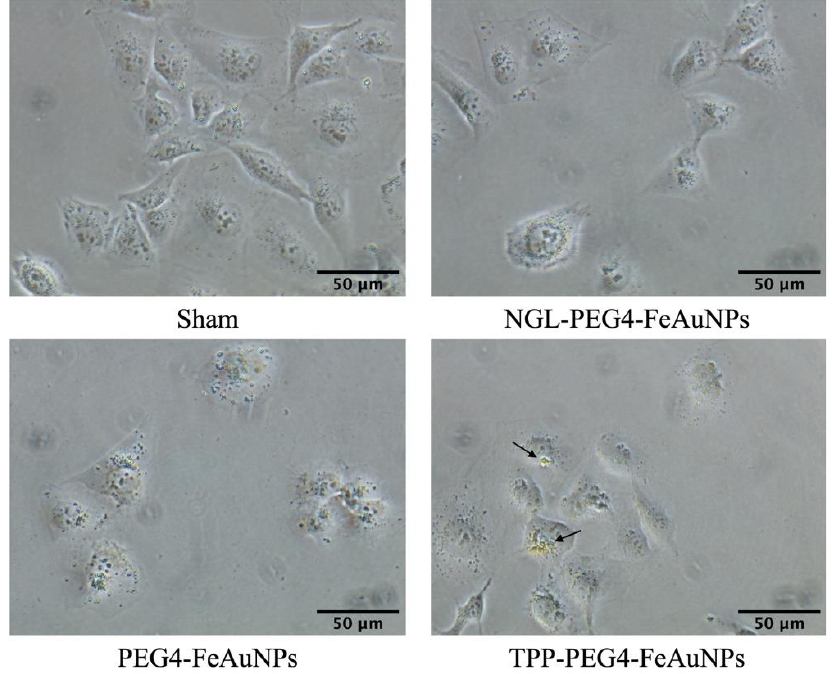
Figure 2. Representative images of MDA-MB-231 cells cultured with TPP-PEG4-FeAuNPs, PEG4- FeAuNPs and NGL-PEG4-FeAuNPs (2.5 µg/mL for 24 h), or after sham treatment. Black arrows show the NP accumulation in MDA-MB-231 cells. Images were recorded with color camera images of transmitted visible light using a 40× objective.